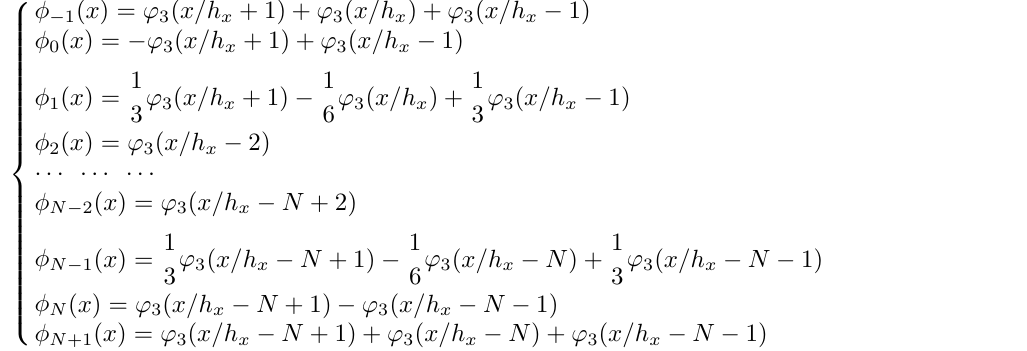
Fig. 3. Plate deflection interpolation by basis cubic B-spline functions ( x -direction).